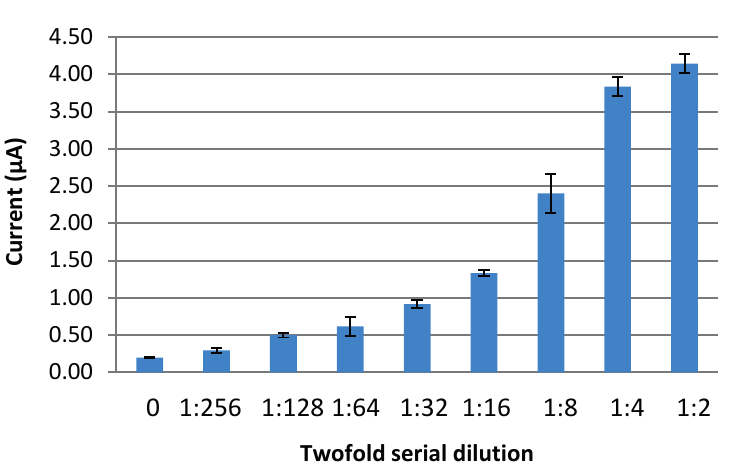
Figure 10. Optimization of serum dilution for the detection of dengue